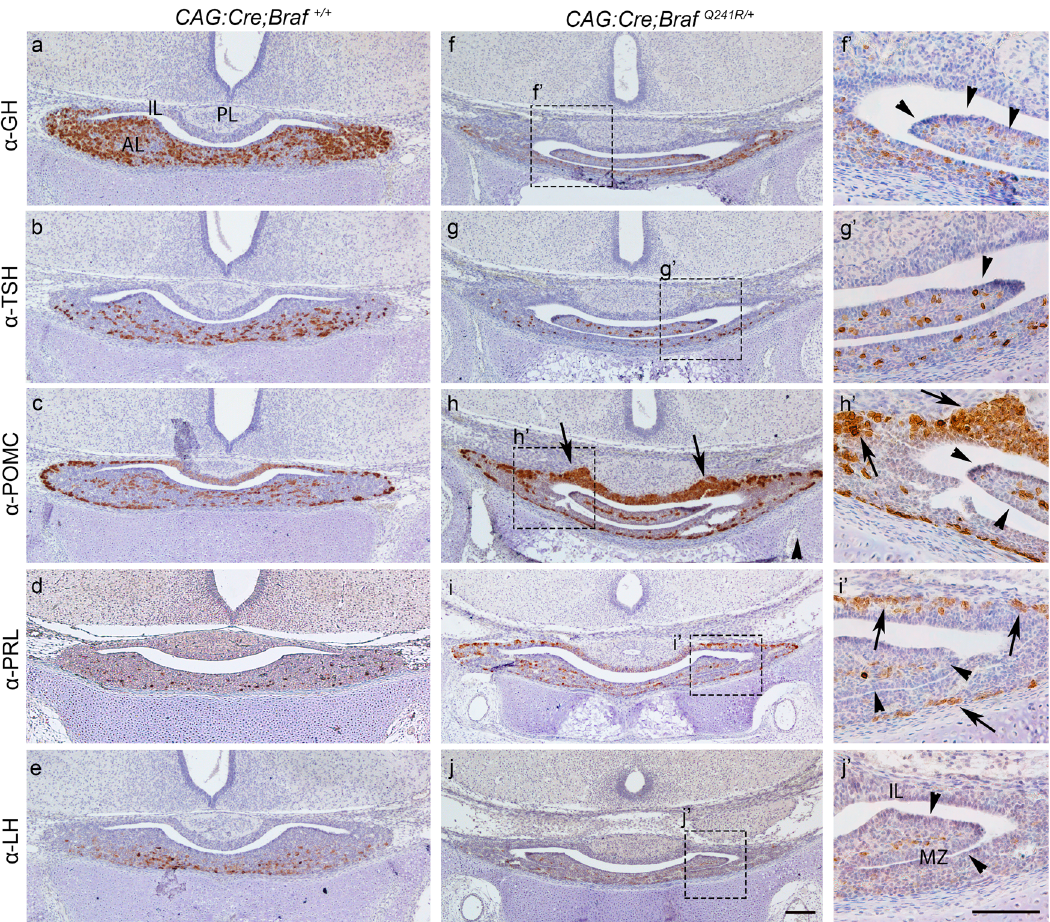
Fig. 6 Abnormal terminal differentiation of hormone-producing cells in the Braf Q241R/ + knock-in allele ( CAG:Cre;Braf Q241R/ + ). IHC against GH, TSH, POMC, PRL and LH hormones on coronal sections of Wt ( a – e ) and mutant CAG:Cre;Braf Q241R/ + ( f – j ) embryos at E18.5. GH ( f ), TSH ( g ) and LH ( j ) were severely reduced in CAG:Cre;Braf Q241R/ + mutant pituitaries compared to Wt. Increase in POMC ( h , h ′ ) and PRL ( i , i ′ ) were found in mutants compared to Wt ( c , d , respectively). f ′ – j ′ represent higher magni fi cation of the boxed areas in f – j , respectively. Note that CAG:Cre;Braf Q241R/ + mutant pituitaries exhibit overgrowth of marginal zone (MZ) with extended growths into the pituitary lumen (arrowheads in f ′ – j ′ ). Images are representative of three embryos per genotype. AL anterior lobe, IL intermediate lobe, PL posterior lobe, GH growth hormone, TSH thyroid-stimulating hormone, POMC proopiomelanocortin, PRL prolactin, LH luteinising hormone. Scale bar: j 200 µ m; j ′ 500 µ